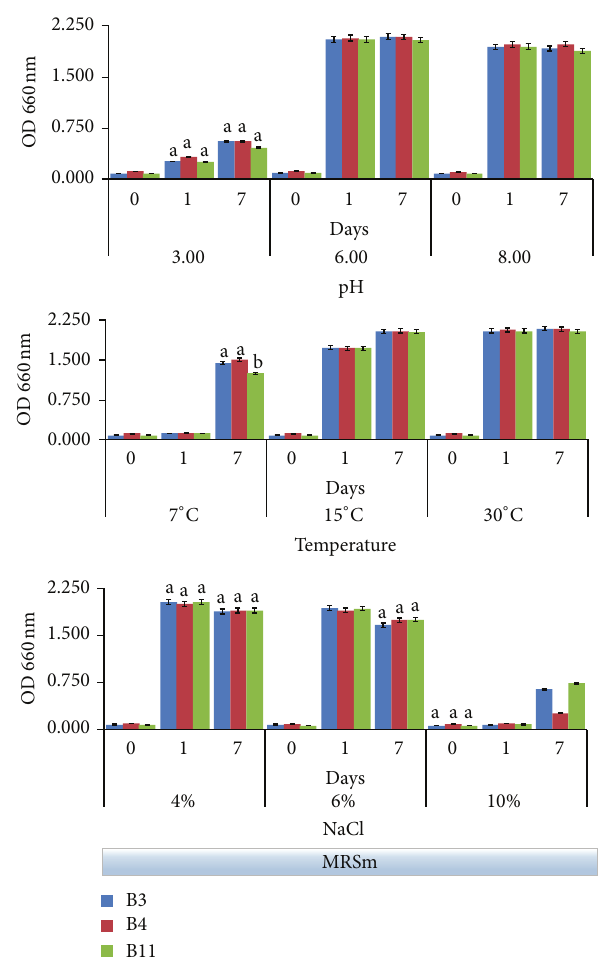
Figure 2: Bacterial growth (OD at 660 nm) in MRSm (modified MRS containing 1% glucose) followed up to 7 days under the following fermentation conditions: pH (3.0, 6.0, and 8.0), temperature (7, 15, and 30 ∘ C), and NaCl concentration (4, 6, and 10%). Data represent the mean and standard deviation of three independent replicates. Only the differences resulting as statistically significant ( 𝑝 < 0.01 ) are indicated with different letters. 30 ∘ C incubation temperature; initial pH